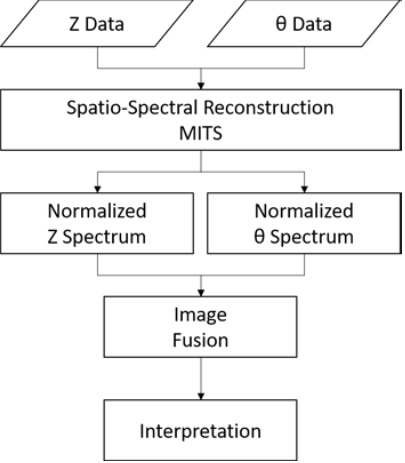
Figure 10. Flowchart of image fusion procedure from amplitude and phase reconstructions.